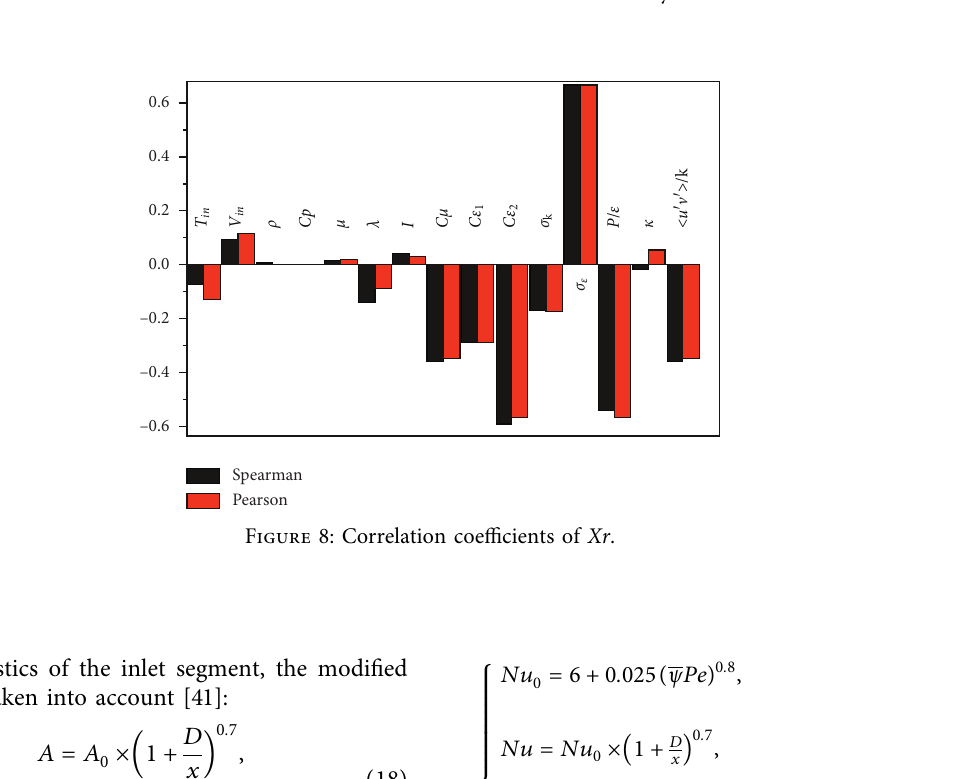
Figure 7: Normalized flow field with 6s uncertainty.